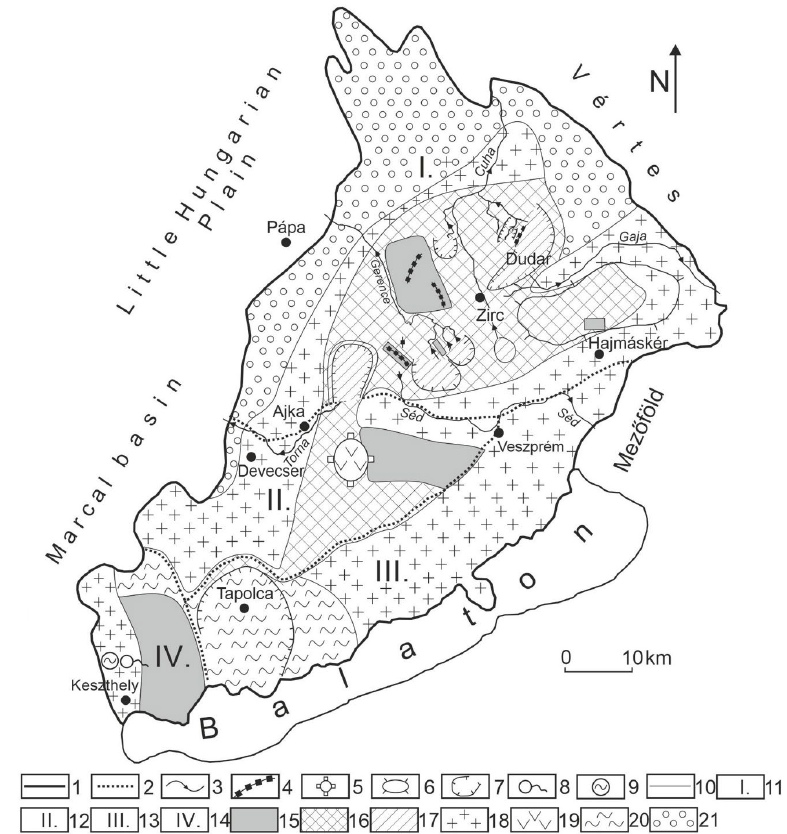
Figure 6. Distribution of horst types in the Bakony Region. Legend: 1. boundary of the mountains, 2. boundary of micro-region group, 3. stream, 4. horst, 5. basaltic horst, 6. plateau, 7. basin, 8. karst spring, 9. karst lake, 10. boundary of horst type, 11. Northern Bakony, 12. Southern Bakony, 13. Balaton Uplands, 14. Keszthely Mountains, 15. horst in summit position, 16. horst elevated to summit position, 17. cryptopeneplain, 18. threshold surface, 19. horst with basalt cap, 20. buttes with basalt cap in karstic and non-karstic environments, 21. hilly country covered with superficial deposit (fluvial sediment, dune